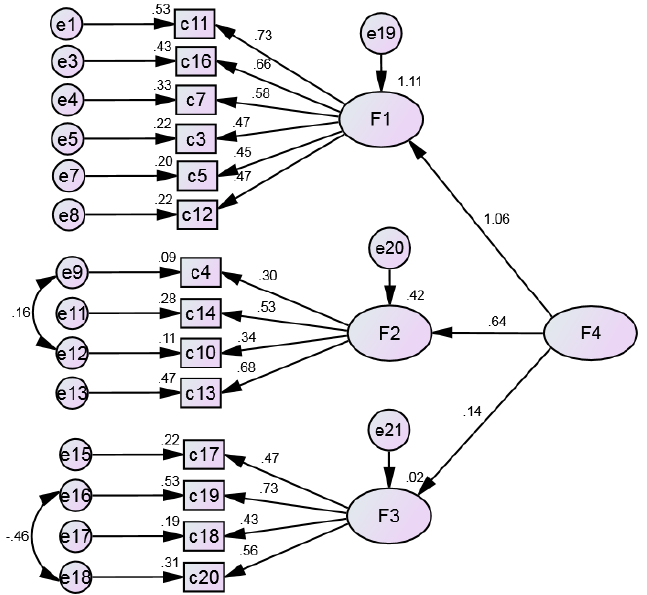
Figure 4. Second-order model.